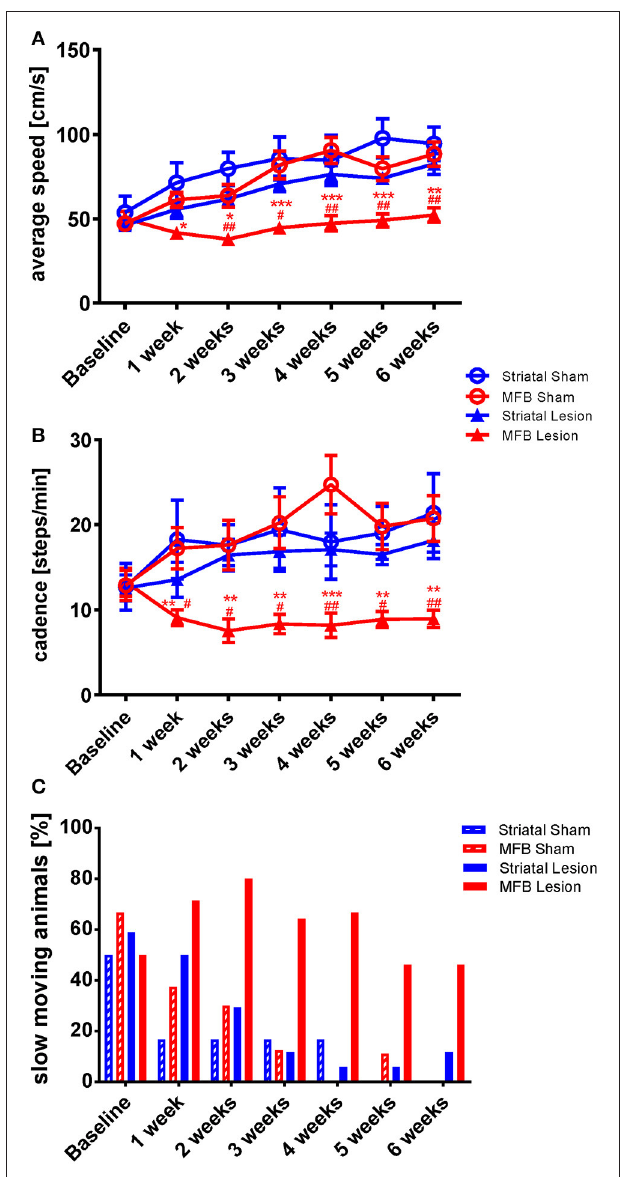
FIGURE 2 | Kinetic variability of gait following MFB or striatal 6-OHDA lesions. Graphs demonstrating the inter-dependent variables (A) average speed of a run, (B) the total number of steps taken per minute (cadence) and (C) the percentage of slow moving rats within each cohort. Data shown as mean ± s.e.m (A,D) or percentage (C) . *Indicates a significant difference on the lesion group when compared to its control (blue for striatal cohort and red for MBF cohort) and # indicates differences of MFB lesion vs. striatal lesion animals. * P ≤ 0.05; ** P < 0.01; *** P < 0.001 (Two-way repeated measures ANOVA with Tukey’s or Dunnett’s post-hoc multiple